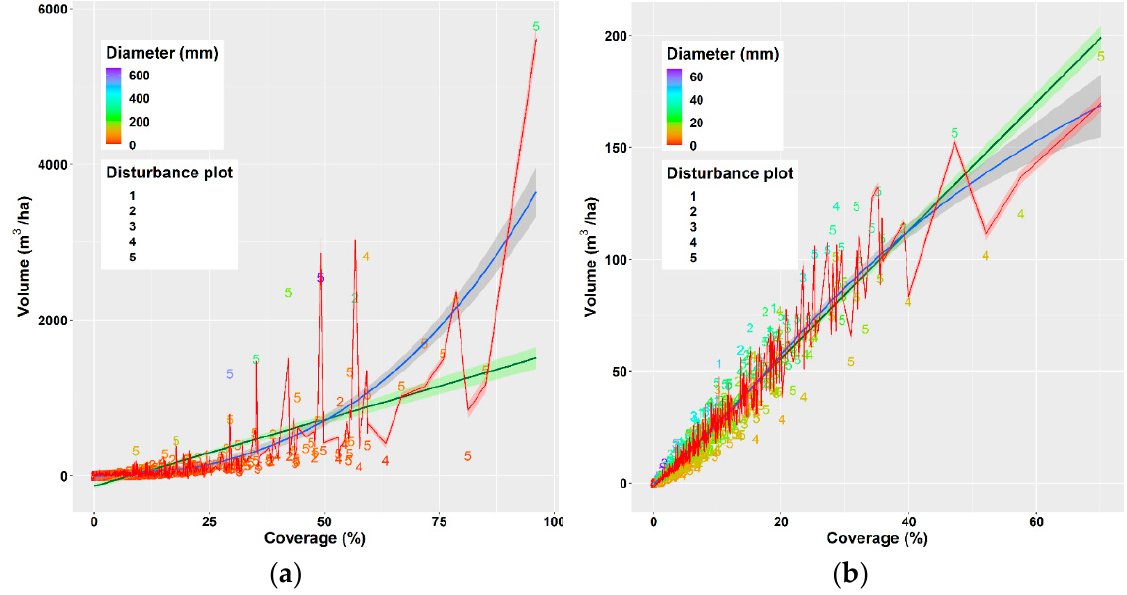
Figure 3. Relationships between volume of deadwood ( a ), volume of fine woody debris ( b ) and its coverage are described with a simple linear regression (green lines), a nonlinear regression (blue lines) or nonlinear models with coverage and diameter as predictors (red lines). Positions of numbers referring to individual disturbance areas in graphs indicate measured values of deadwood coverage and volume and their colours indicate the values of respective mean deadwood diameter.